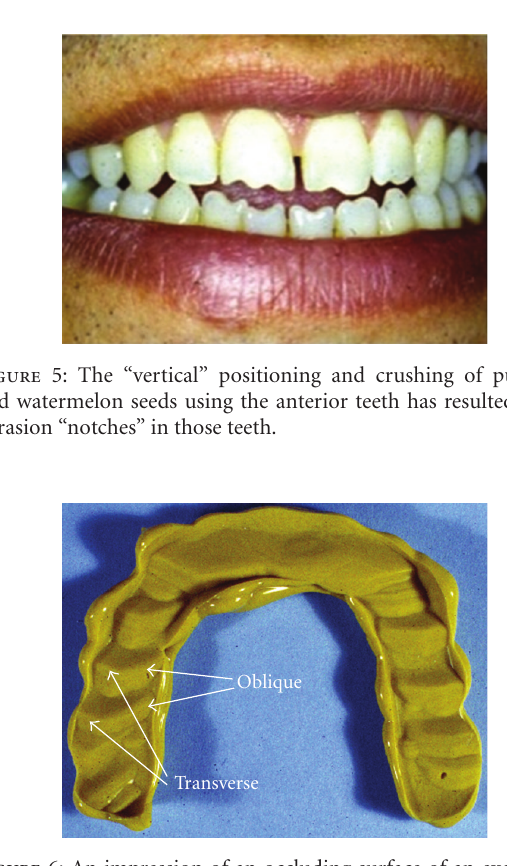
Figure 6: An impression of an occluding surface of an excessively worn night guard. The transverse and oblique wear patterns indicate the lateral mandibular movement that formed them. In clinical and micrographic assessments, the wear pattern would be evident as